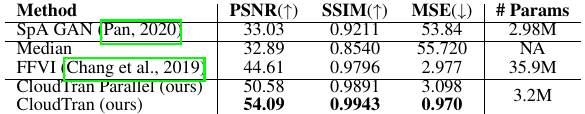
Table 4. Comparison with cloud removal baselines for 64 × 64 outputs.